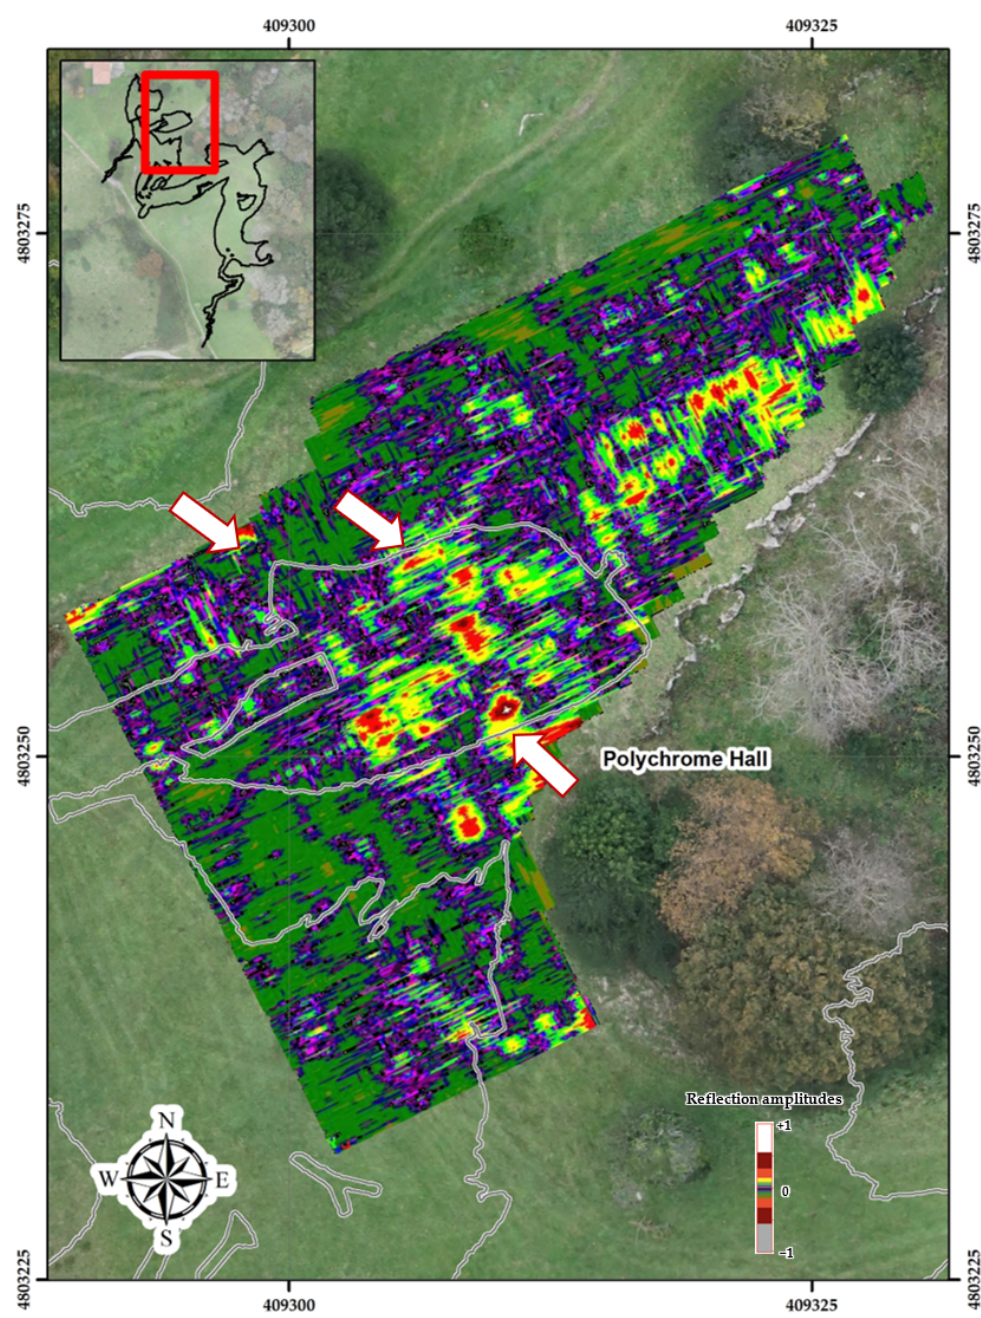
Figure 15. Amplitude slice, 3.50 m depth with the 400 MHz antenna, showing with white arrows the locations of the projections of the vertical/subvertical fractures that correspond to the 3 zones of temporary water inflow observed in the interior of the Polychrome Hall. Two of them are on the north wall and one is on the south wall .